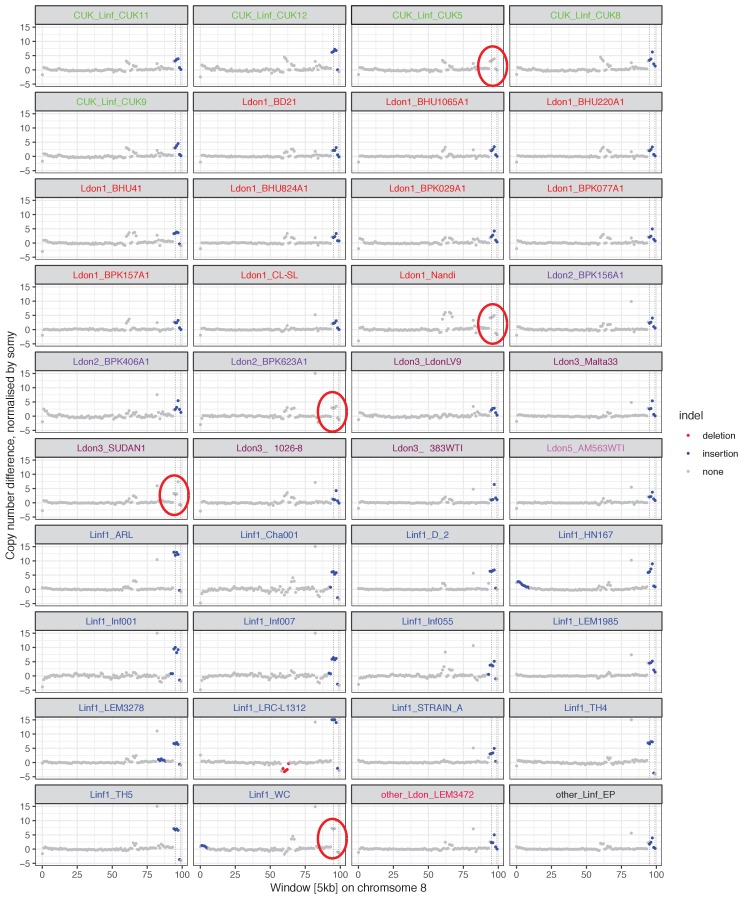
Indication of a putative assembly error in the reference genome.A common duplication of 25 kb on chromosome 8, position 470–495 kb, was found in 35 samples across eight different groups (indicated by vertical bars and highlighted in blue). When inspecting remaining samples, however, a copy number increase was also present in all other 116 remaining samples, which failed to meet the CNV calling threshold. Five of these 116 samples are also shown and the non-called copy number increase is indicated by a red circle. As the copy number increase varies between samples, these regions may still be copy number variable between isolates.